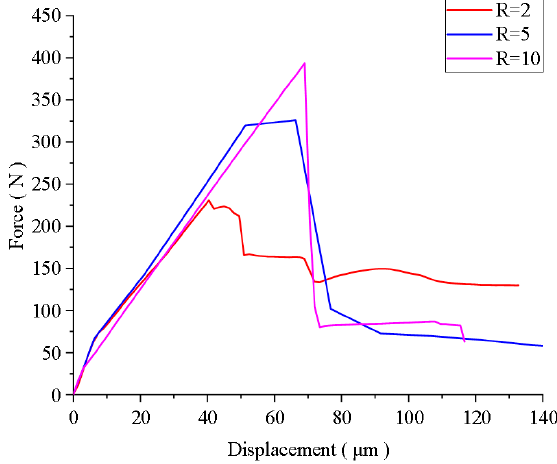
Figure 8. Force–displacement curve of the Al 2 O 3 /ZrO 2 -laminated ceramic specimen under bending.